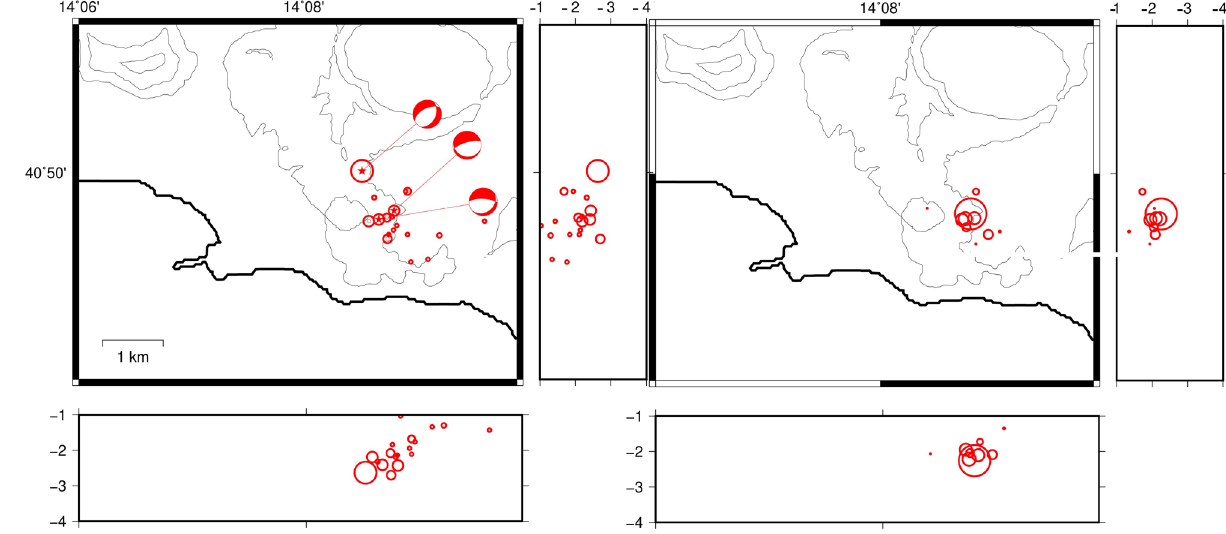
Figure 6. Location of the earthquakes of the swarm of 6/12/2019 obtained using NLLoc (sx) and HypoDD (dx). Circle sizes are proportional to the earthquake magnitude. The images were obtained using the free software